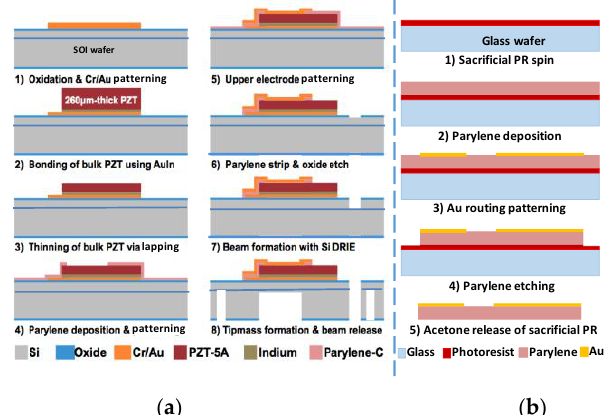
Figure 2. Fabrication flow of the piezoelectric transducer ( a ) and flexible parylene carrier ( b ). SOI wafer has a 30 μm device layer, 2 μm buried oxide and 300 μm handle layer. Parylene thickness of the carrier is 20 μm.